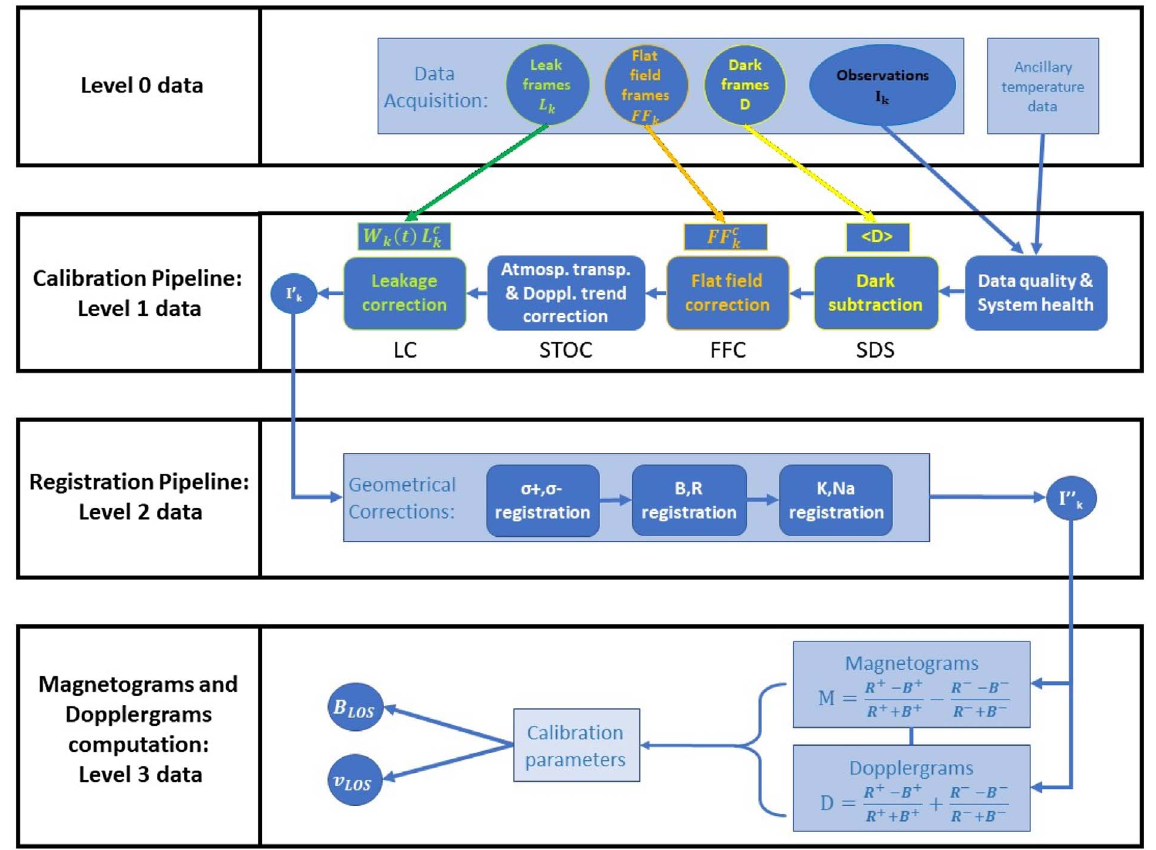
Fig. 4. Overview of the Data Reduction Pipeline. The data reduction pipeline for the MOF-based synoptic telescopes consists of three modules, which, respectively: subtract the dark; compute and correct for the fl at fi eld frame FF c j . evaluate and correct for the atmospheric extinction and the orbital trend; compute and subtract the leak calibration frame L c j ; The registration module consists of other three modules,which, respectively: compute and apply the polarization registration ( r + , r (cid:1) ), compute and apply the wings registration (B,R), compute and apply the channels registration (K, Na). The fi nal module computes the K and Na line-of-sight magnetogram ( B (cid:3) LOS ) and Dopplergram ( V (cid:3) LOS ) synoptic